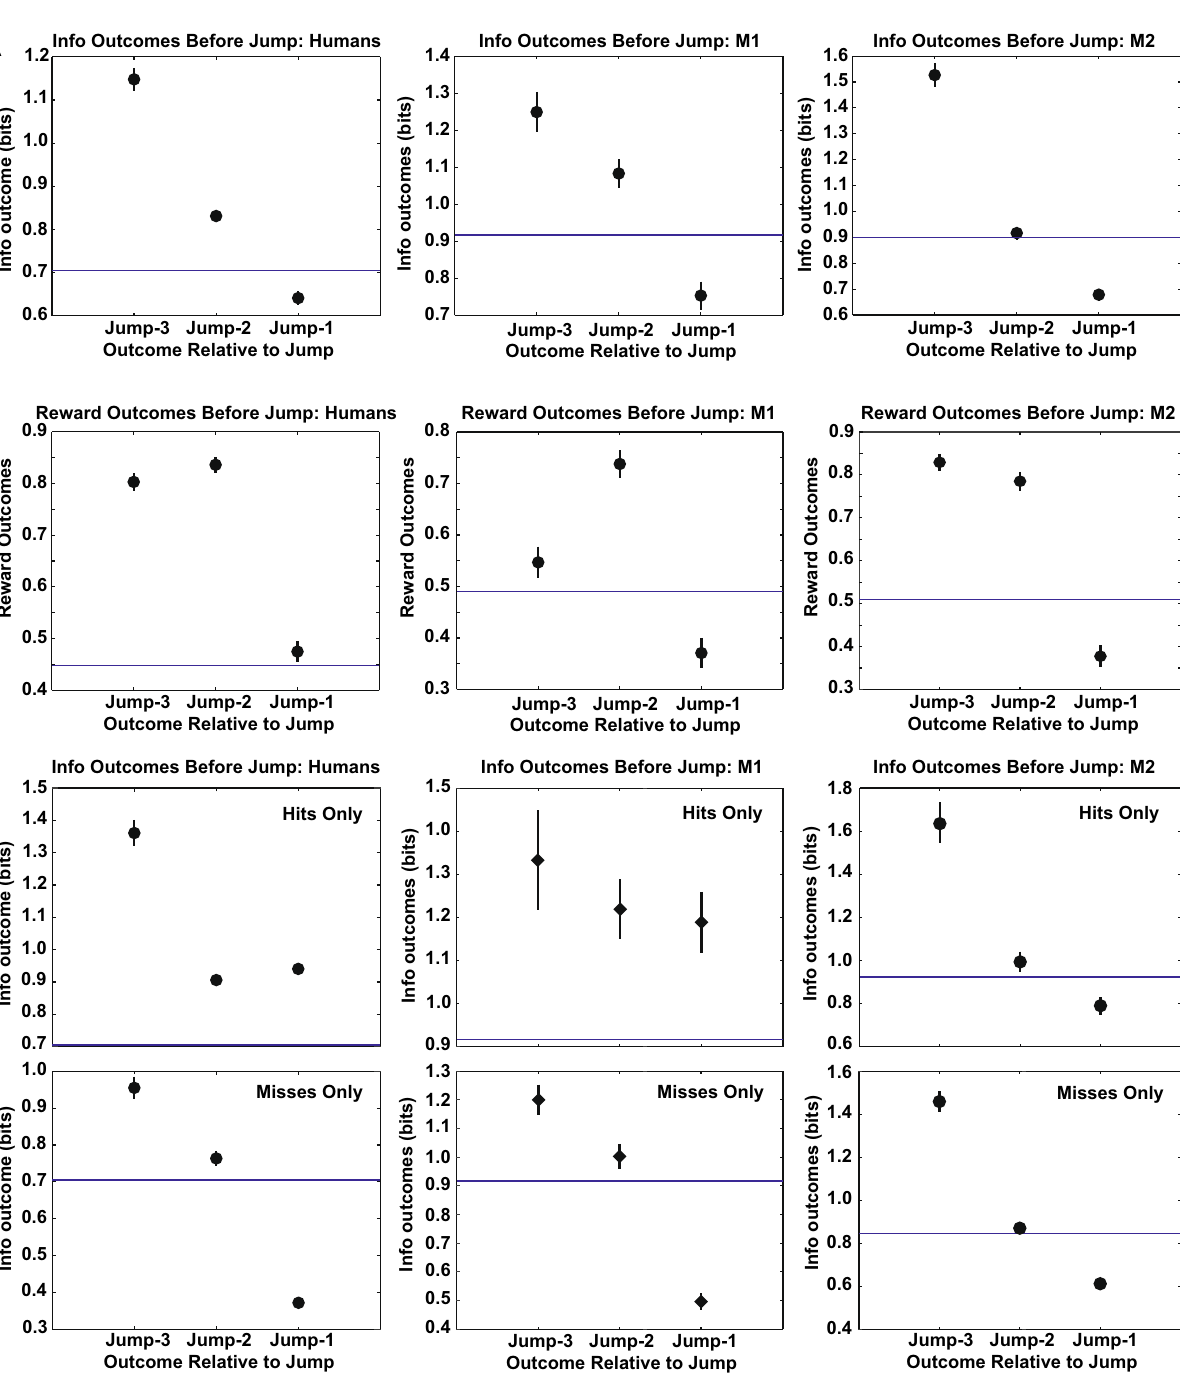
Figure 5. Information and reward outcomes three choices before a jump, two choices before a jump, and the choice before a jump. ( A ) Left: human information foraging; Middle: M1; Right: M2. ( B ) Left: human reward foraging; Middle: M1; Right: M2. Note that the reward outcome for a choice before a jump for humans was not below the average reward outcome across all choices. ( C ) Information outcomes three choices before a jump broken out by choice outcome just prior to jump, either ‘Miss’ (bottom panels) or ‘Hit’ (top panels). Humans: left pair of panels; M1: middle pair of panels; M2: right pair of panels. Points: mean, error bars: ± 1 s.e.m. Error bars sometimes occluded by points. ( A – C) All trials during learning